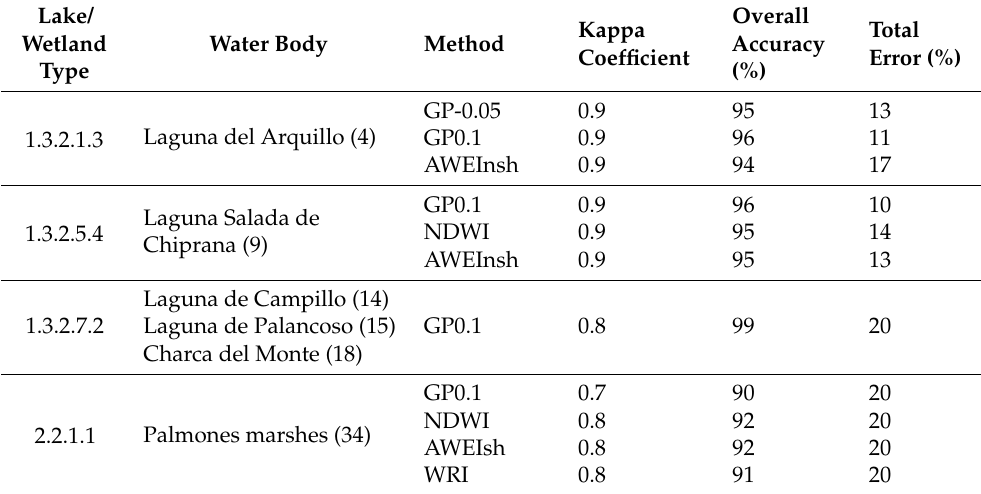
Table 5. Summary of accuracy assessment of the different water estimation methods using Sentinel- 2A/2B imagery. Note that only those yielding total error (omission + commission) values lower than 20% are listed.